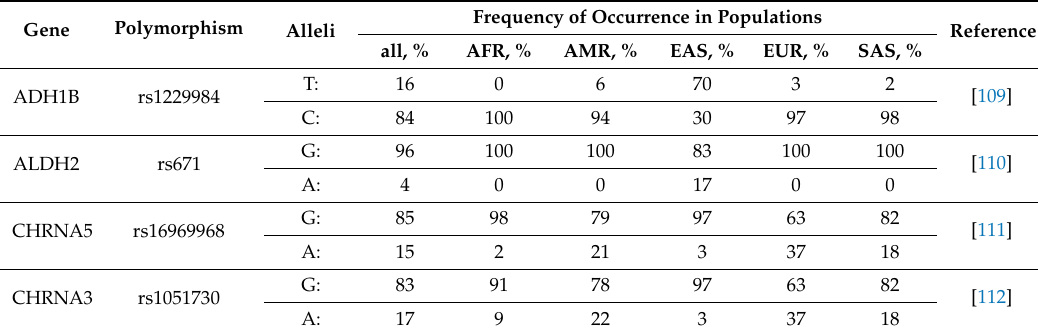
Table 7. Populational genetics of genes responsible for food addiction.